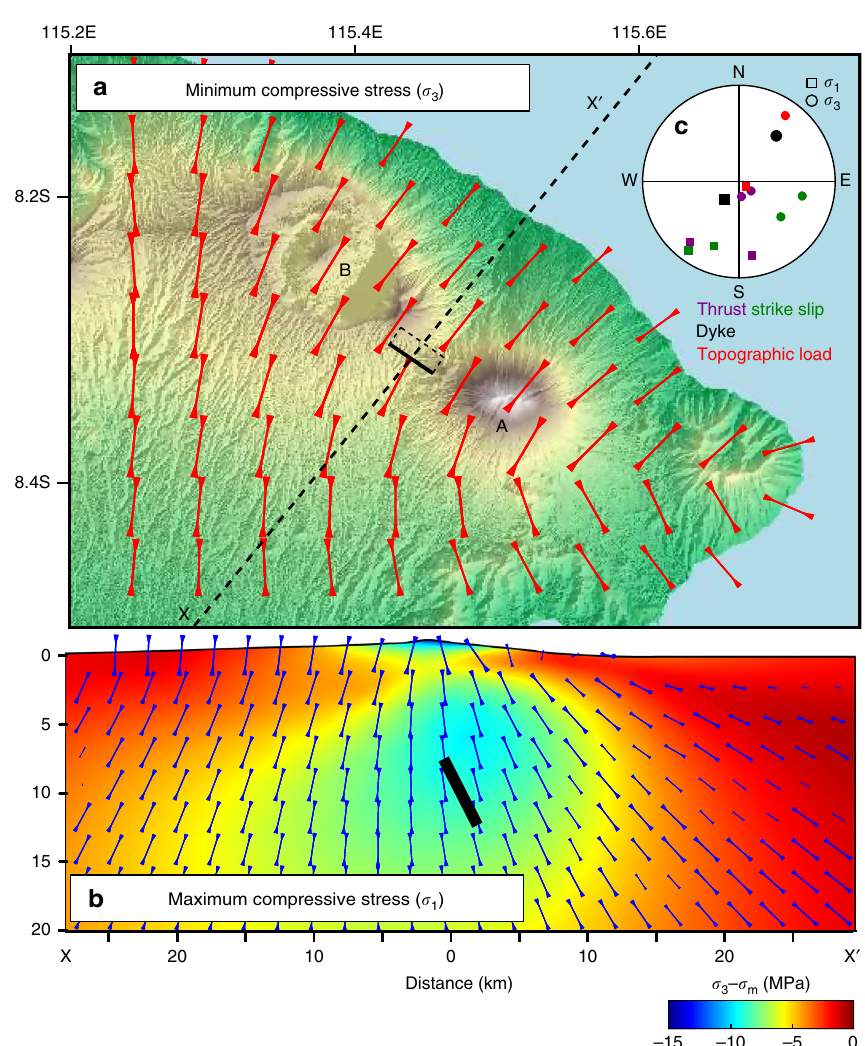
Fig. 6 Effect of the topographic load on the emplacement of the magma intrusion. a Orientation of the minimum compressive stress ( σ 3 ) at 10 km bsl (equivalent to the depth of the dyke). The small black rectangle represents the dyke (bold line being the top edge). b Depth pro fi le across the dyke (see location in ( a )) showing the orientation of the maximum compressive stress σ 1 as well as the minimum deviatoric stress ( σ 3 − σ m ), with σ m being the mean stress. c Stereographic projection showing the direction of σ 1 and σ 3 for the tectonic stresses (focal mechanism of thrust and strike-slip earthquakes), the inferred dyke (FEM-based inversion of InSAR data) and the topographic loading (FEM stress